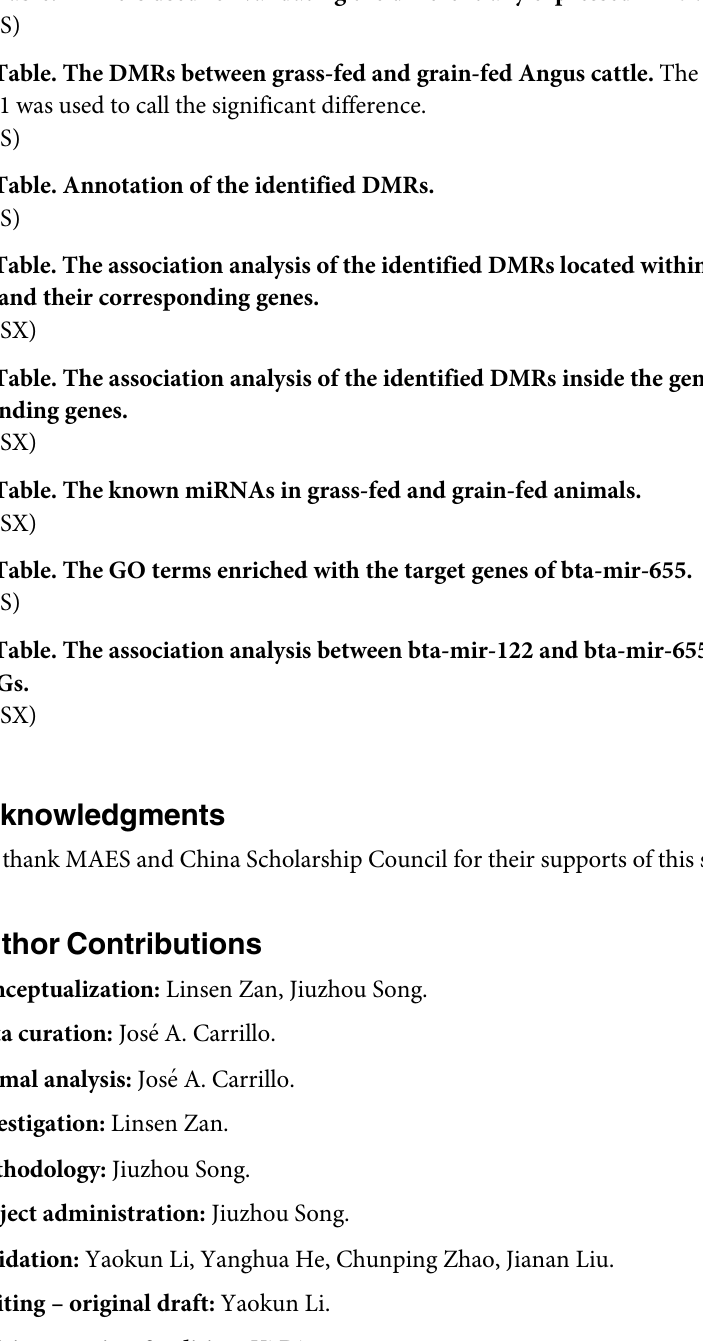
S2 Fig. Validation of differentially expressed miRNA. The mean value of log2 (fold-change) for each group was compared in the bar chart. FC means fold-change. S1 Table. Primers used for validating the randomly selected DMRs. S2 Table. Primers used for validating the differentially expressed miRNA. S3 Table. The DMRs between grass-fed and grain-fed Angus cattle. The threshold of FDR < 0.1 was used to call the significant difference. S4 Table. Annotation of the identified DMRs. S5 Table. The association analysis of the identified DMRs located within the genes promot- ers and their corresponding genes. S6 Table. The association analysis of the identified DMRs inside the genes and their corre- sponding genes. S7 Table. The known miRNAs in grass-fed and grain-fed animals. S8 Table. The GO terms enriched with the target genes of bta-mir-655. S9 Table. The association analysis between bta-mir-122 and bta-mir-655 and their targeted